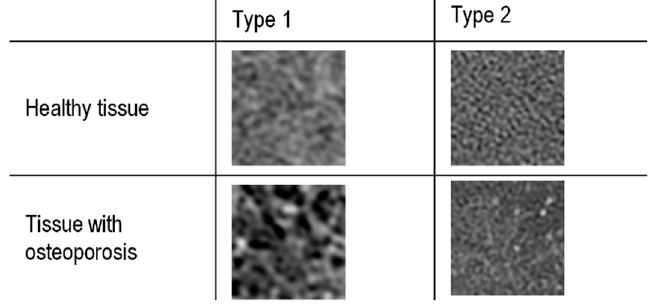
Figure 3. Spongy matter structure in soft-tissue (Type 1) and bone reconstruction (Type 2).